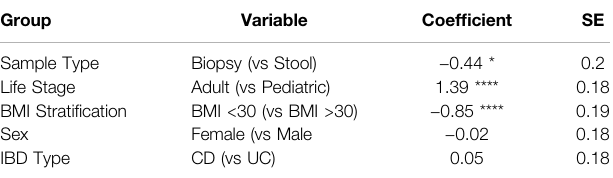
TABLE 3 | Model performance for different sample types and patient demographics. Samples with available metadata were categorized into groups based on the collection method or the patient ’ s speci fi c demographic group based on sex, age,and BMI. Predictive performance for all combinations of taxonomic features, compositional transformations, zero-centering batch effectcorrection,andnon-linearmodelswereincludedintheanalysis.Logistic regression was performed to assess the performance differences within each sample and demographic group while adjusting for the remaining covariates. **** indicates p -value < 0.0001, and * indicates p -value <